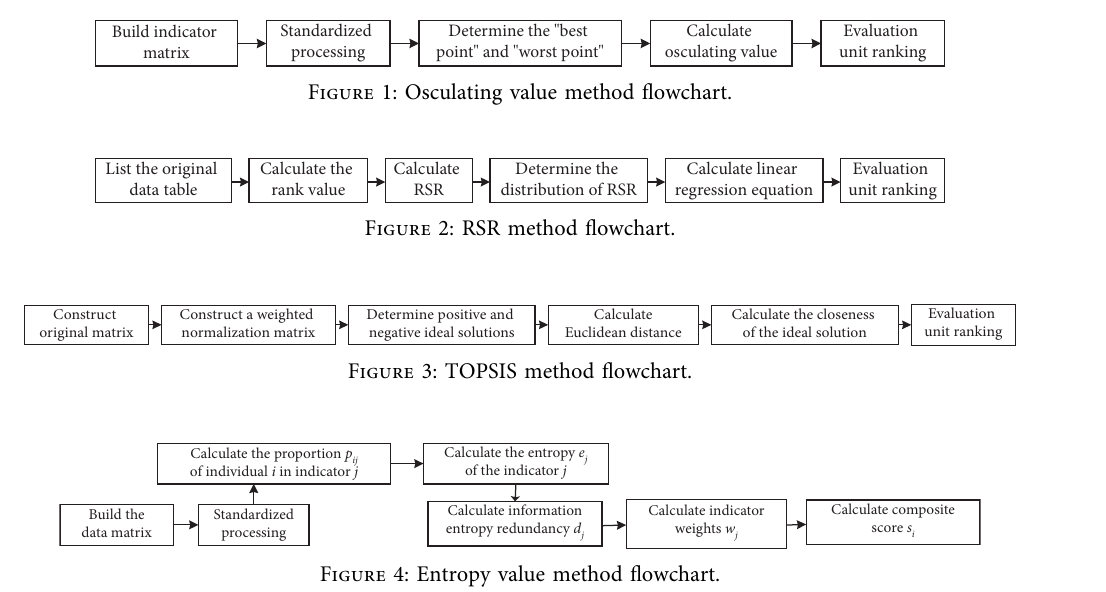
Figure 4: Entropy value method flowchart.